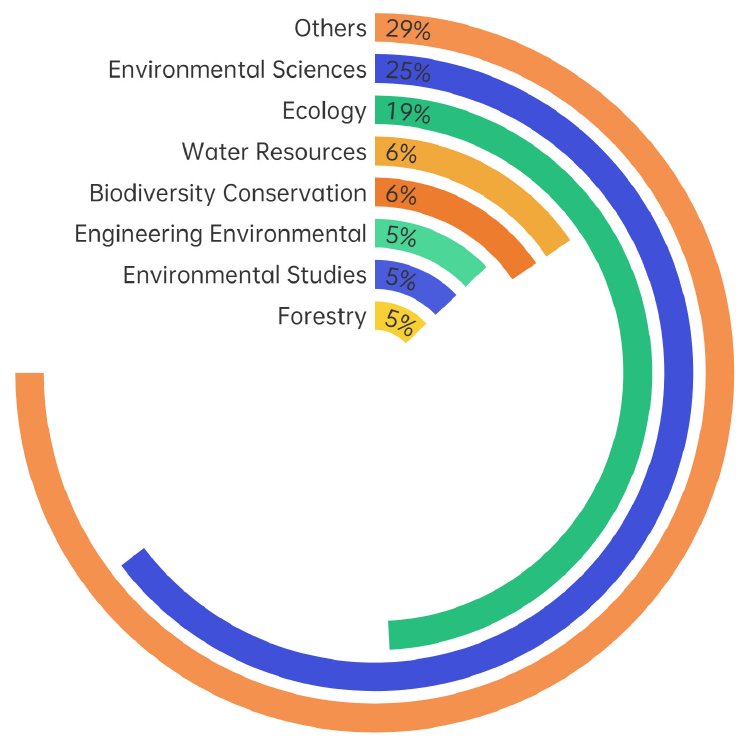
Figure 6. Average annual citations in the field of ecological restoration from 1990 to 2021.